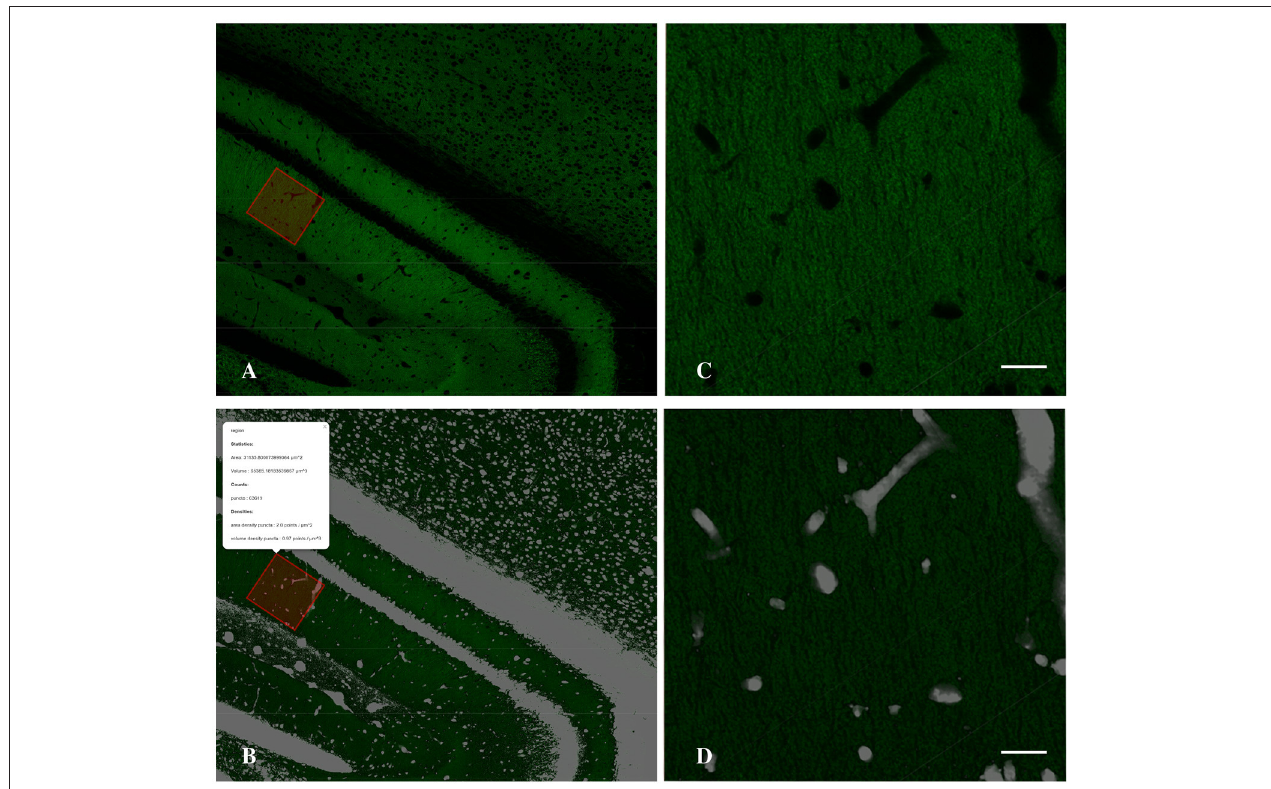
FIGURE 4 | Detail of the Graphical Interface of MultiMap, showing CA1 hippocampal region (A) and the computed holes layer (B) and the result of the density estimation over a selected region (inset). (C,D) Higher magnification images of selected region shown in A,B , respectively. Scale bar is 20 µ m.